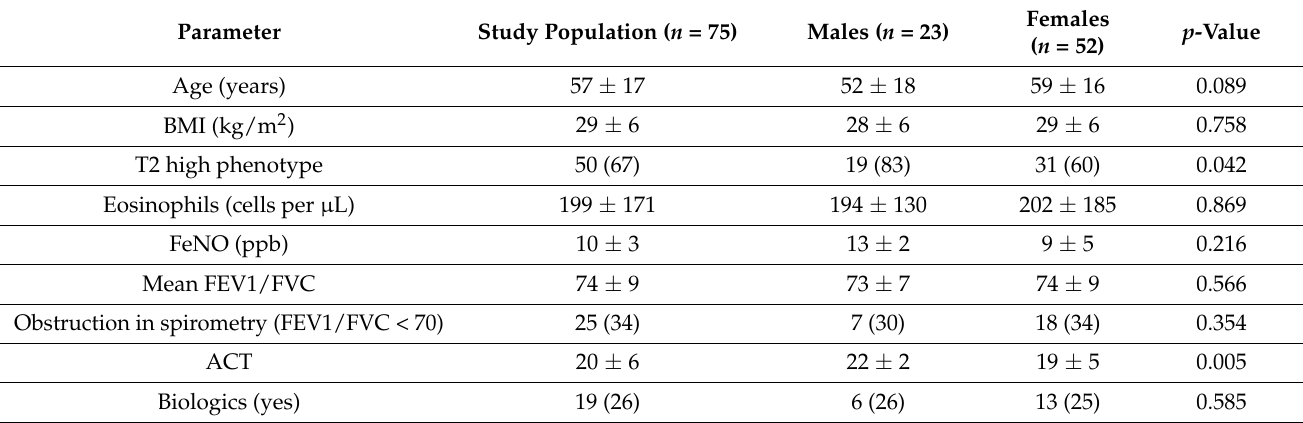
Table 1. Demographic, clinical and spirometric characteristics of the asthmatics ( n = 74).